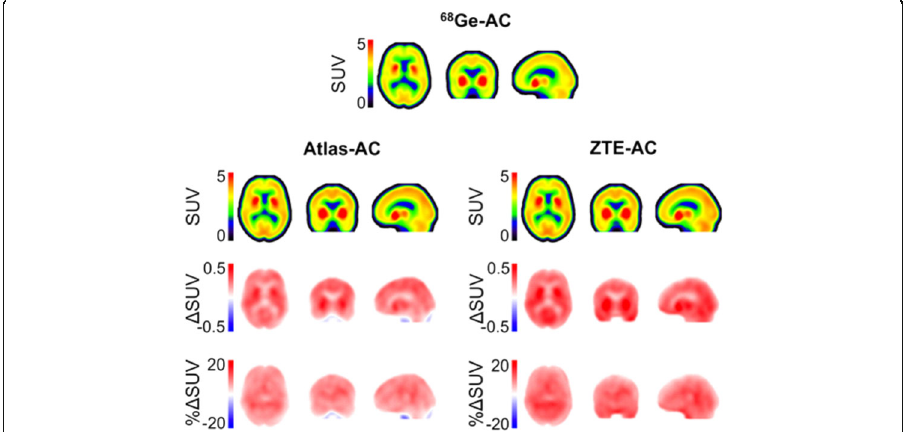
Fig. 2 Mean 11 C-PE2I SUV images using 68 Ge-AC (first row) as well as atlas-AC and ZTE-AC (second row). Below, average absolute and relative SUV images illustrating absolute ( Δ SUV) and relative (% Δ SUV) differences between atlas-AC (left) and ZTE-AC (right) compared to 68 Ge-AC